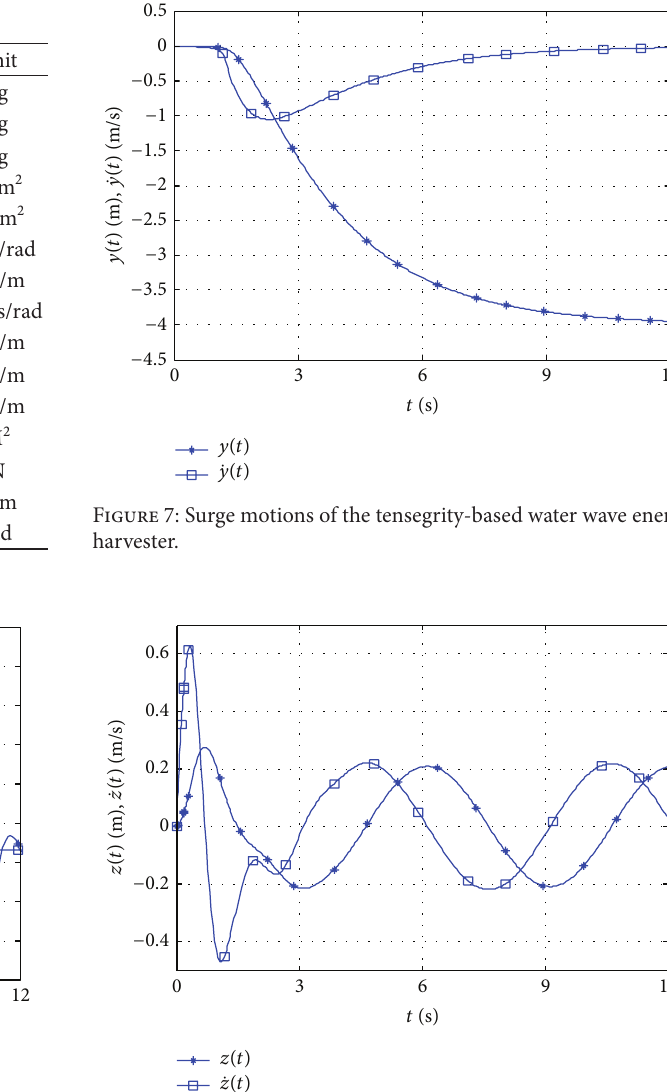
Table 2: Tensegrity-based harvester coefficients.